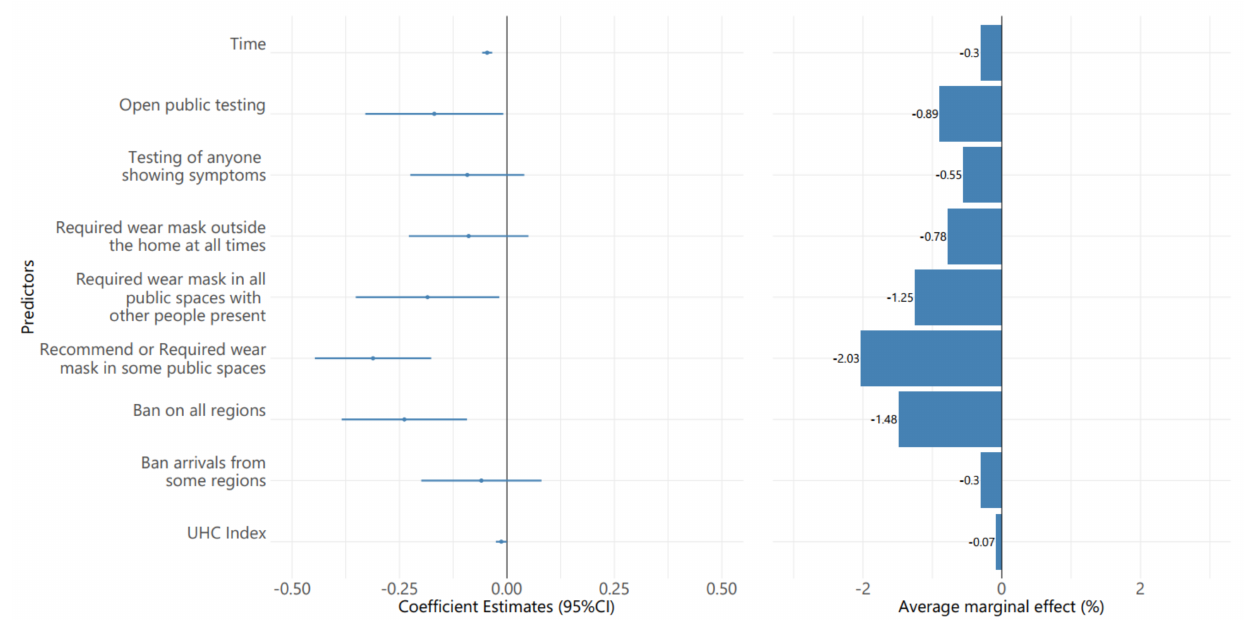
Figure 4. The effectiveness of NPIs on average daily growth rate (wADGR) among Asian countries in the pre-vaccination